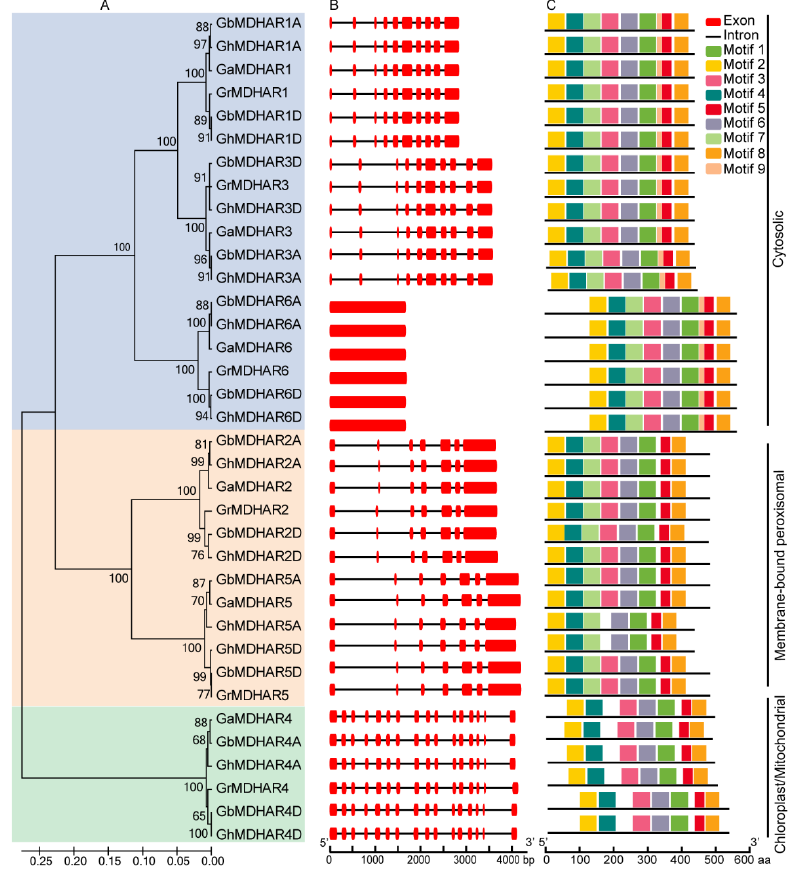
Figure 3. Gene organization and conserved motif analysis of the MDHAR gene family in four Gossypium species. ( A ) The cotton MDHARs were classified into three typical clusters which indicated the consistency with that in Figure 2. ( B ) Gene structures of the MDHARs are indicated with introns by black lines and the exons by red boxes. ( C ) A total of nine conserved motifs were discovered and indicated by different colored boxes with the specific distributions presented and the amino acid length displayed at the bottom. Both the intron/exon organizations and conserved motifs of the MDHARs demonstrated similar distributions in the same